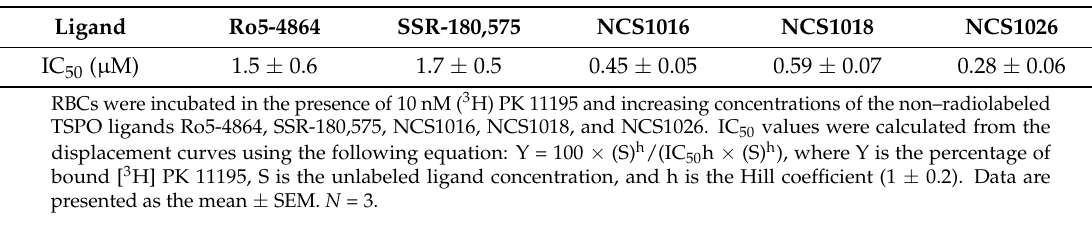
Table 1. Translocator Protein (TSPO) ligands’ affinity for RBC membranes.